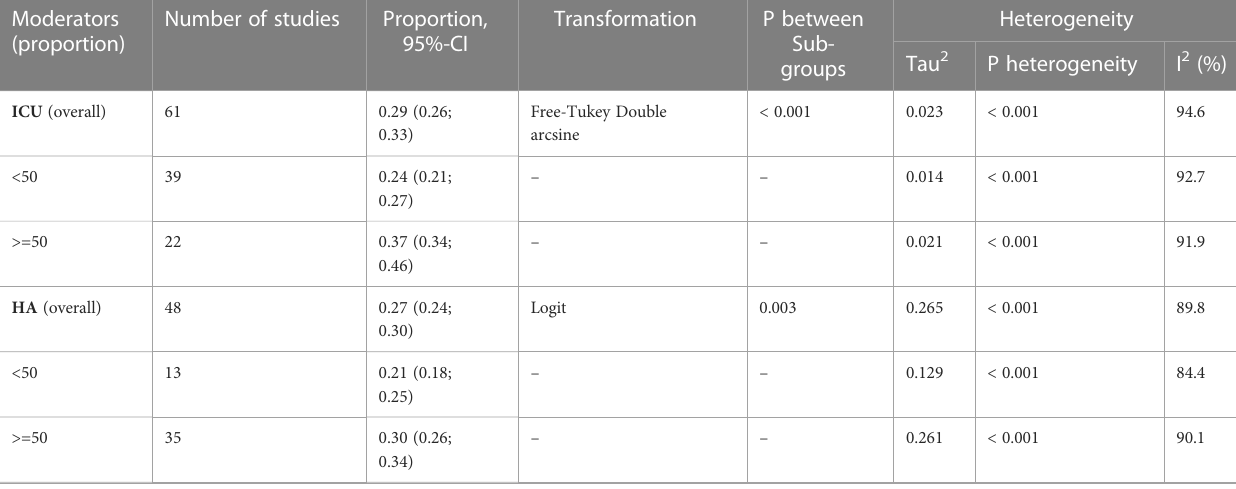
TABLE 2 Subgroup analyses on single proportion of 30-day